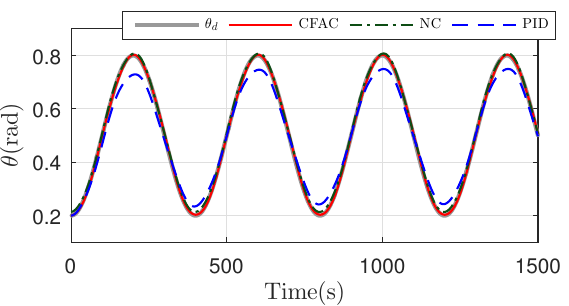
Figure 24. Pitch angle tracking performance in floating motion with a constant velocity and variable pitch angle